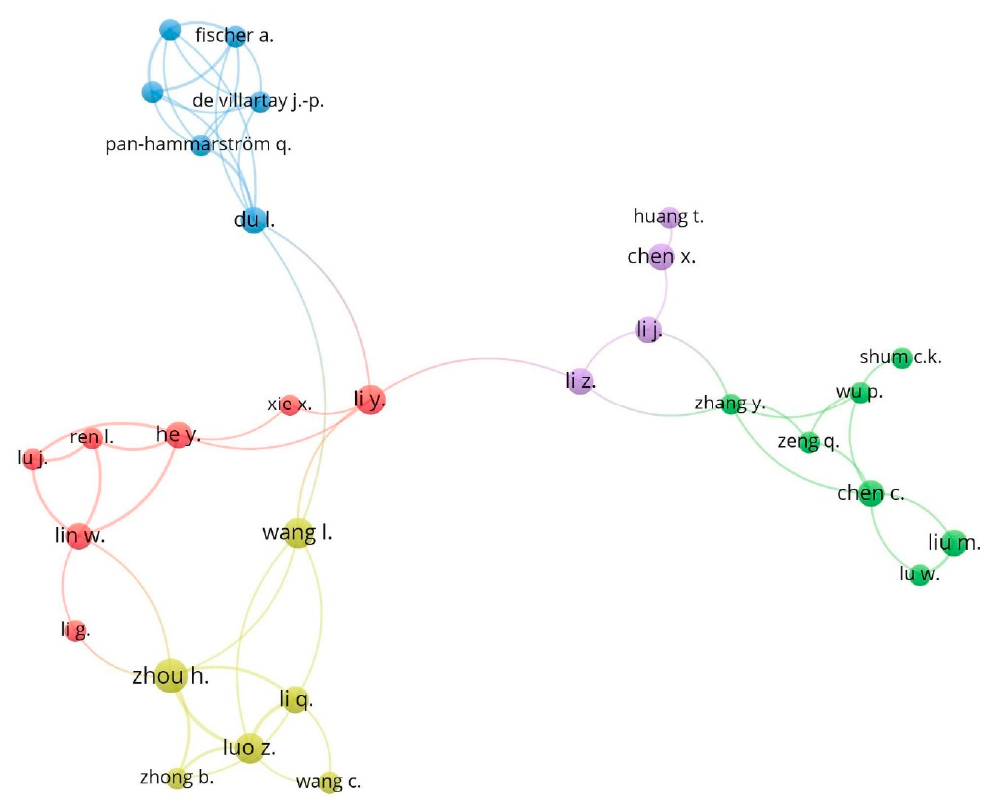
Figure 5. Network of cooperation between authors based on co-authorship (1970- 2019).